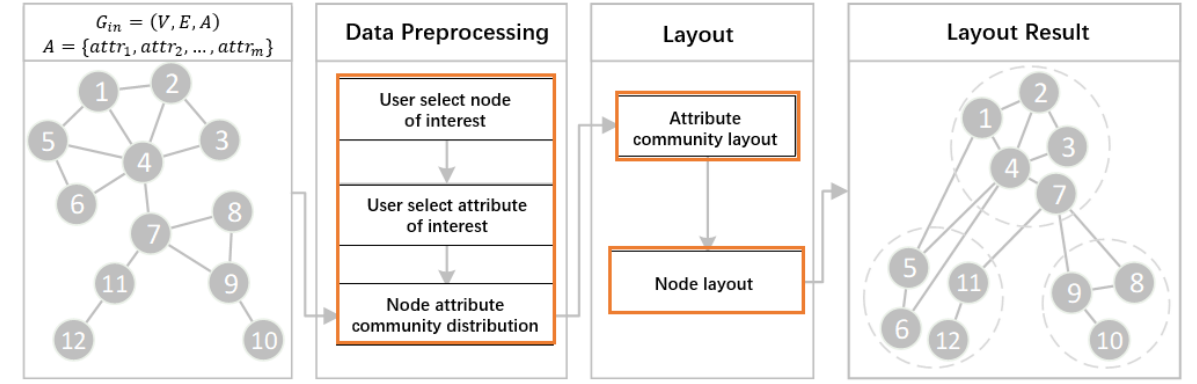
Figure 1. The general framework of our